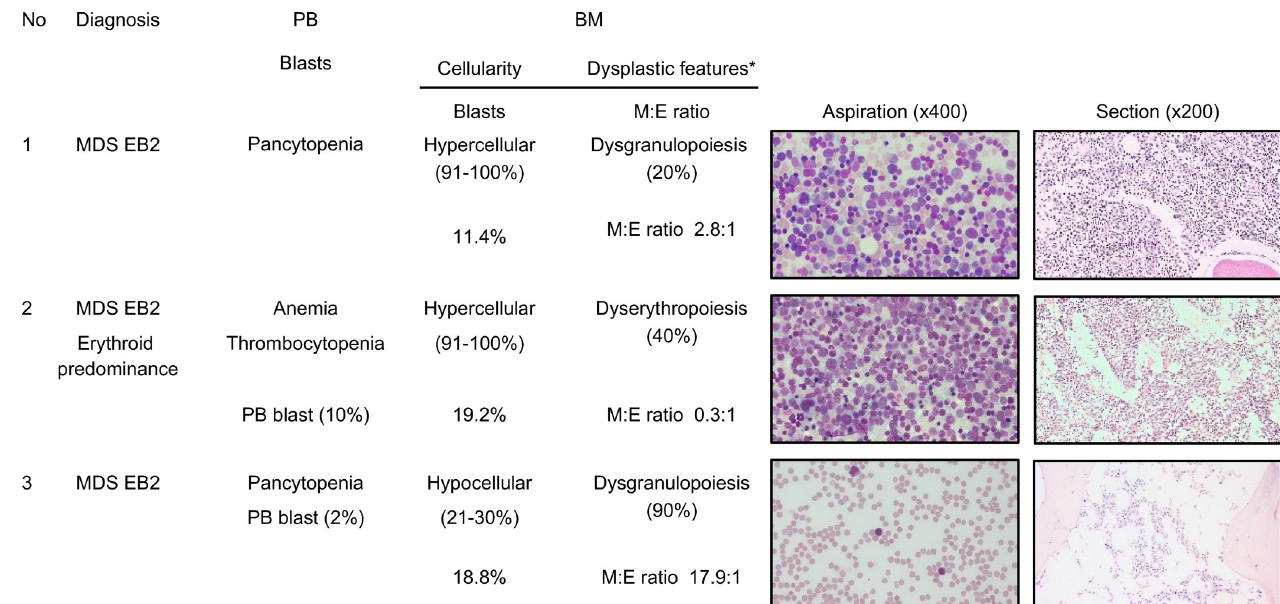
Fig 1. Summary of bone marrow examinations of the three patients with refractory cytopenia of childhood (RCC). BM, bone marrow; MDS, myelodysplastic syndromes; BM, bone marrow; MDS-EB2, myelodysplastic syndromes with excess blasts-2.